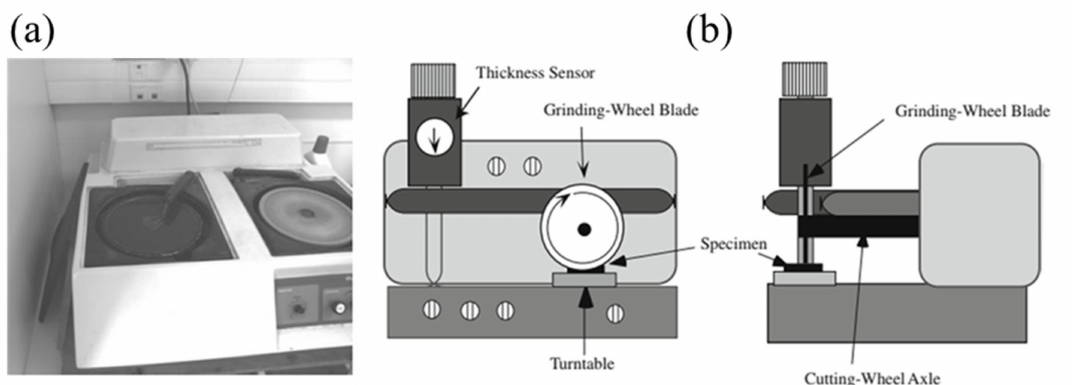
Figure 12. ( a ) Rotary grinder/polisher, ( b ) dimpling diagram [124]. Reprinted from [124] with permission from Springer Science & Business